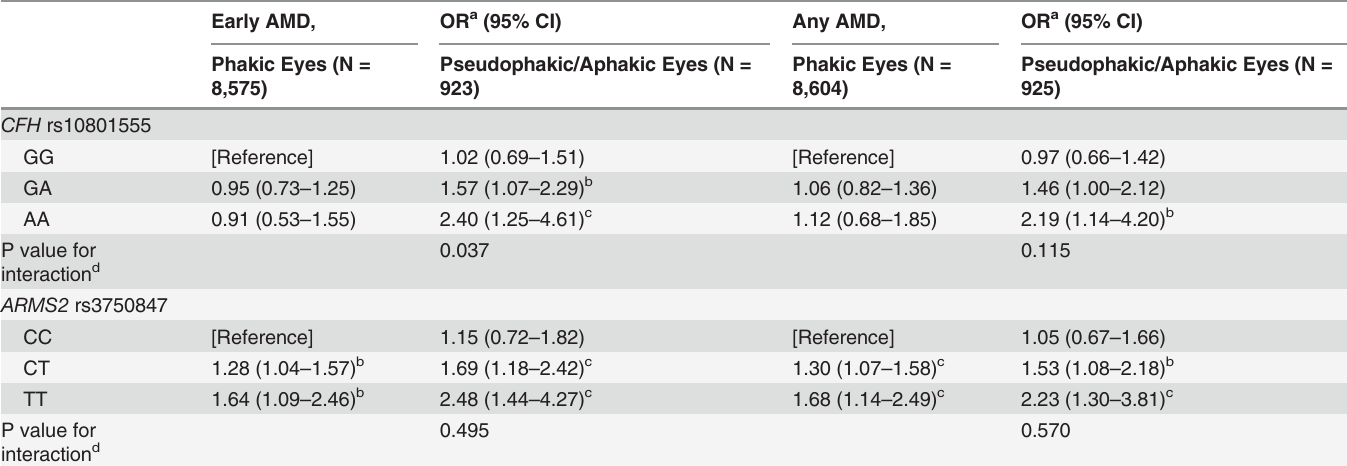
Table 5. Joint effects of lens status and CFH/ARMS2 SNP on risk of early AMD and any AMD.